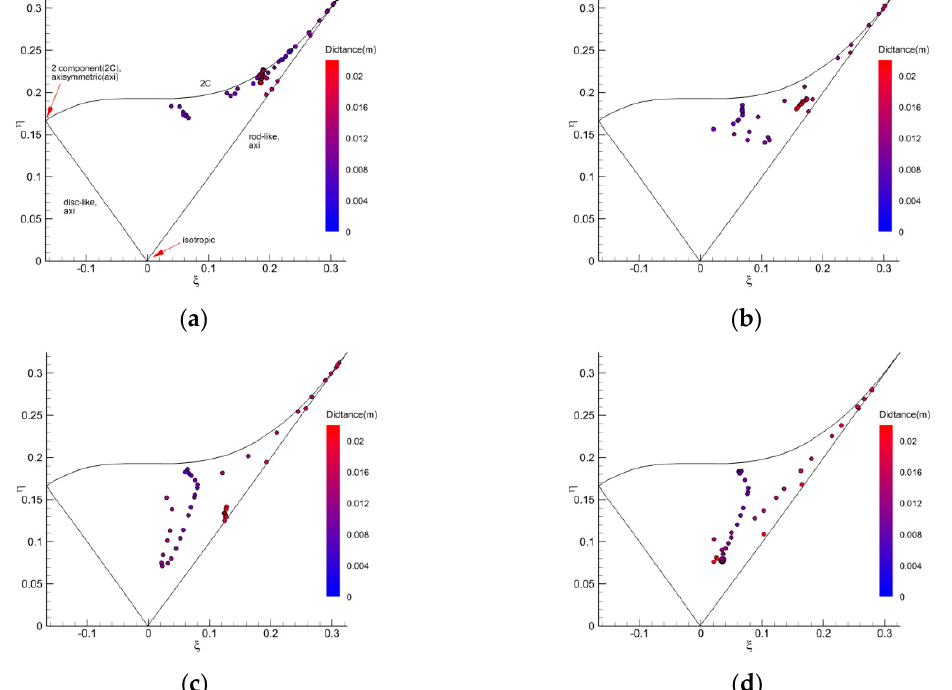
Figure 18. Distribution of points from the extracted lines in the Lumley triangle at 20% span: ( a ) No.1; ( b ) No.2; ( c ) No.3; ( d ) No.4.